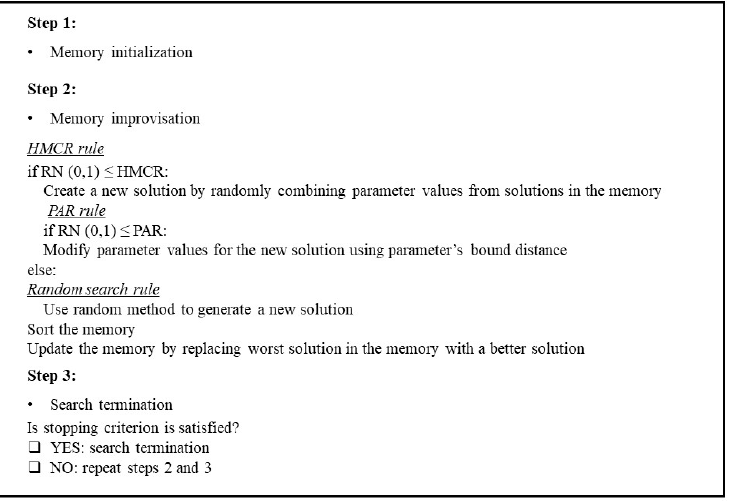
Figure 2. General structure of Harmony Search (HS) algorithm. Harmony Memory Consideration Rate (HMCR) and Pitch Adjustment Rate (PAR) are control parameters used in HS.